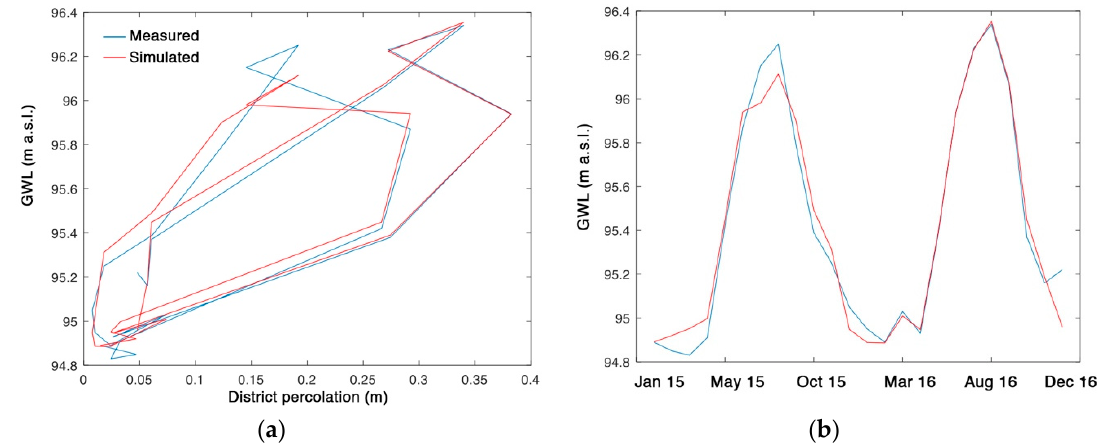
Figure 7. ( a ) Observed monthly groundwater levels (GWLs) versus district total percolation estimated by means of the simulation system for the years 2015 and 2016 (‘direct flow path’); ( b ) Simulated versus measured monthly GWLs series.